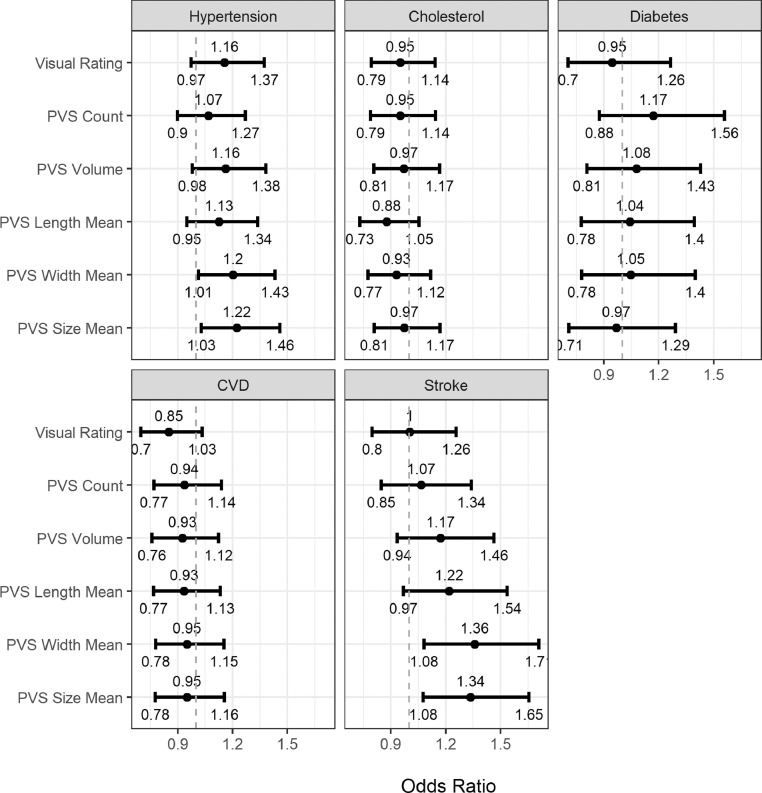
Odds ratios and 95% confidence intervals for visually rated PVS and computational PVS count, volume, length, width and size associations with vascular risk factors, CVD (cardiovascular disease) history and stroke. The vertical dotted line indicates the line of no effect, i.e.1.